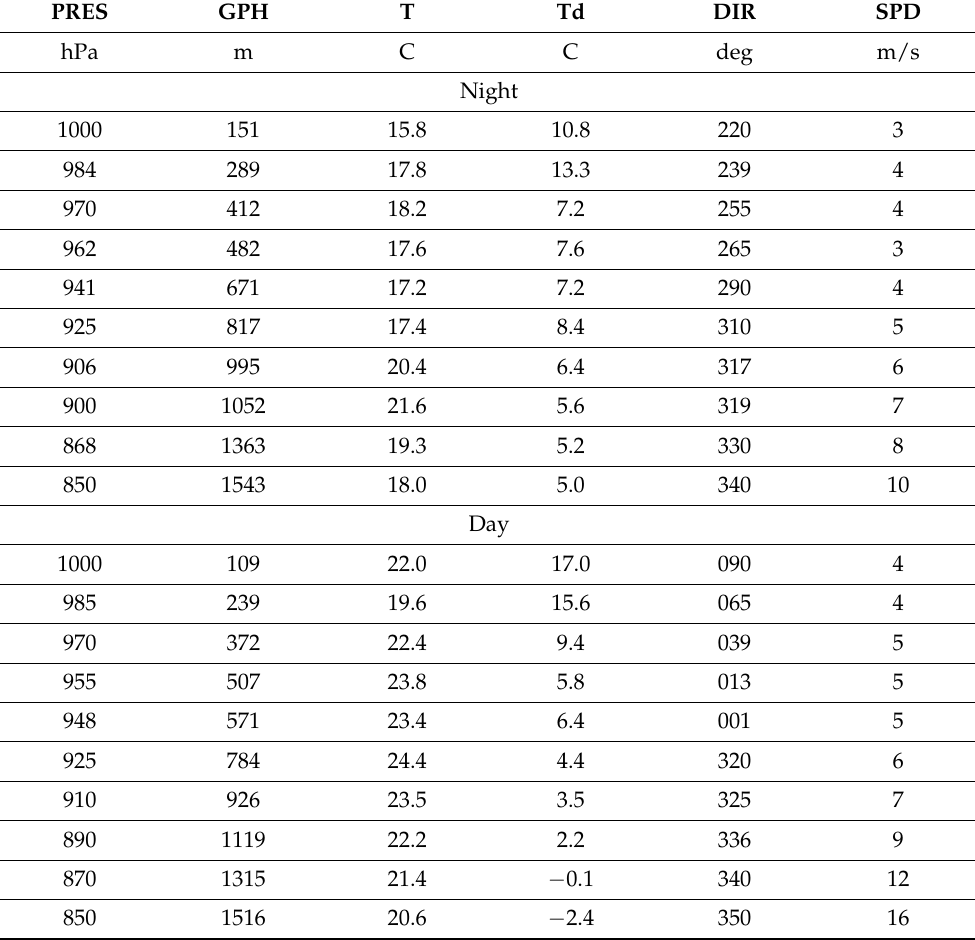
Table 6. Durban radiosonde profiles 00:00 & 09:00 UTC 16 July